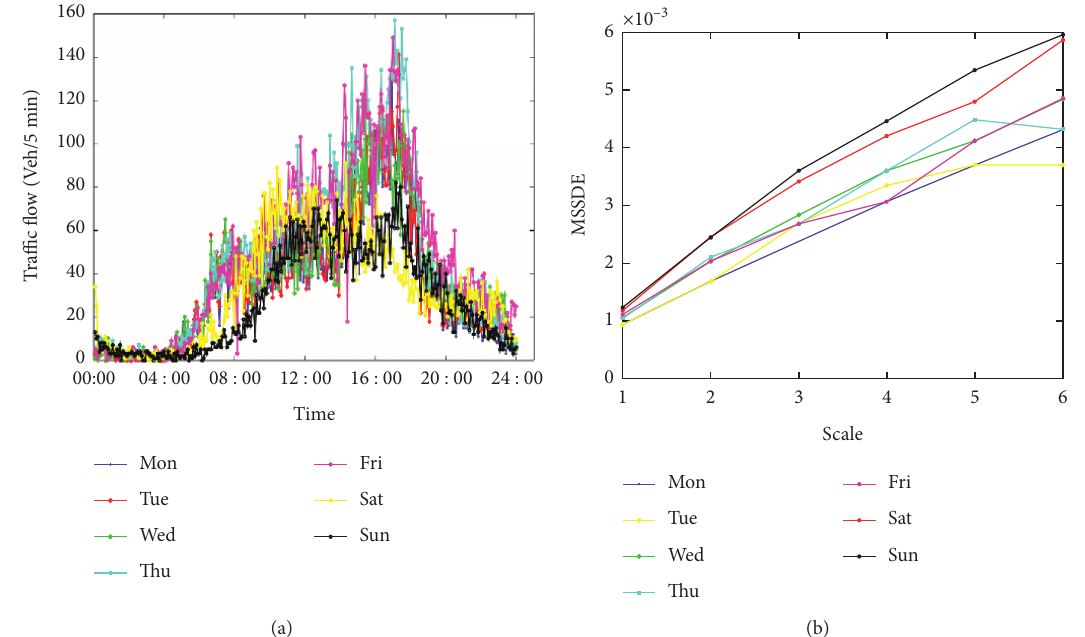
Figure 9: The result of traffic data collected by detector 5570. (a) The traffic data collected of week model from Monday to Sunday. (b) The result of analysis on the traffic day using the proposed